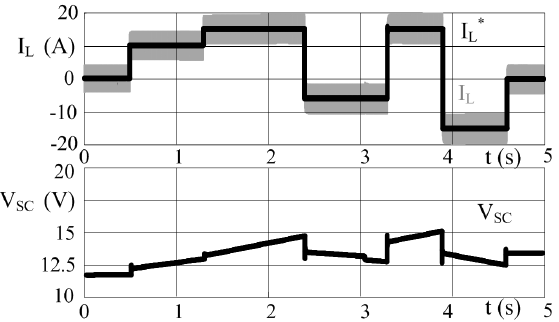
Figure 17. Simulation of inductor current I L (gray, upper plot) and supercapacitor (SC) voltage V SC (black, lower plot) during step changes in the commanded current (black, lower plot). Positive current corresponds to charging mode, negative to discharging